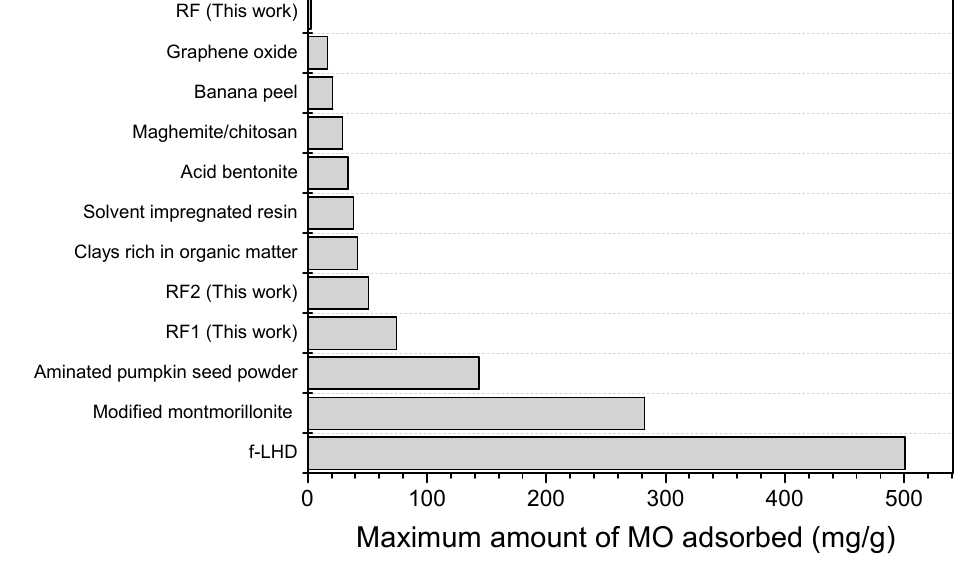
Figure 10 . Comparison of (cid:1843) (cid:3040)(cid:3028)(cid:3051)(cid:3030)(cid:3028)(cid:3039)(cid:3030) of the MO dye for different adsorbents studied in the literature. Figure 10. Comparison of Q calc max of the MO dye for di ff erent adsorbents studied in the